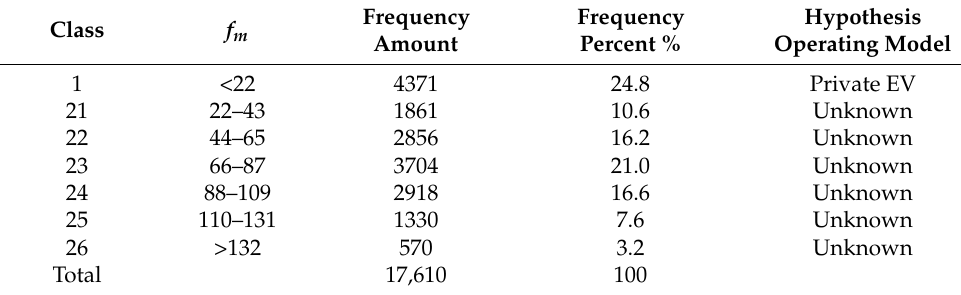
Figure 6. Comparison diagram of subdivided EV operation models. Table 2. Summary of data